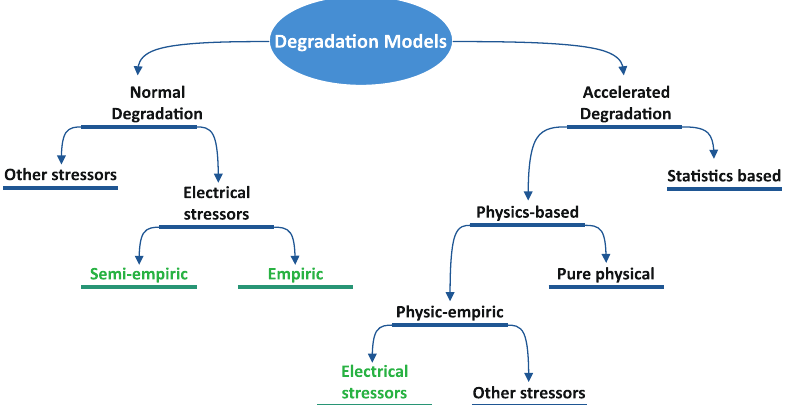
Figure 1. Classification of degradation models in reliability analysis, based on the information presented in